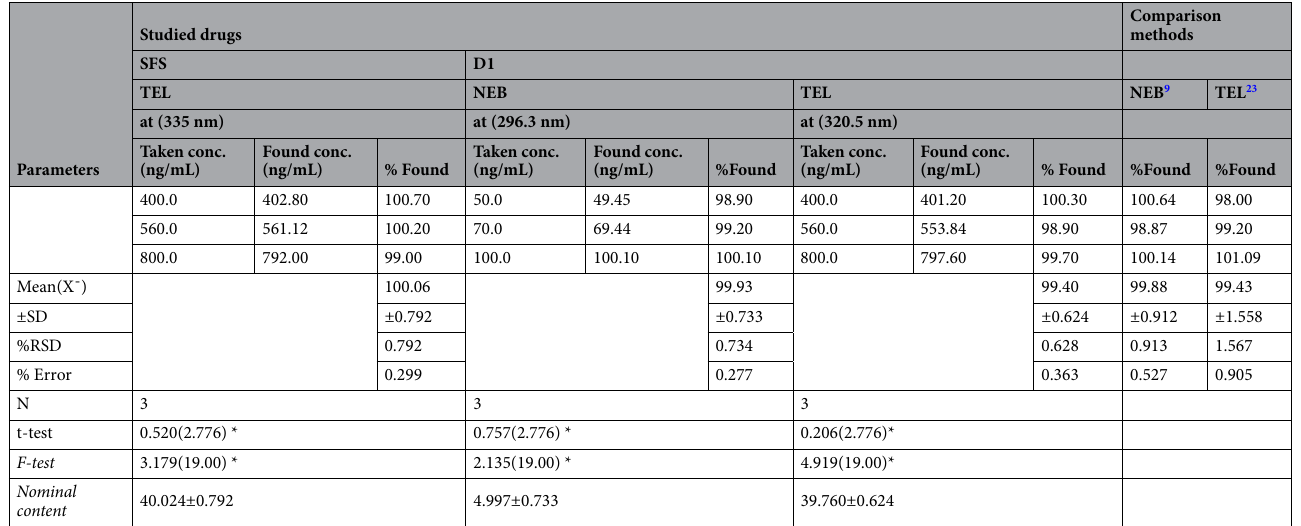
Table 5. Determination of TEL and NEB in dosage forms using the synchronous and first derivative synchronous spectrofluorimetric methods. N.B. Each result is the average of three separate determines. *The values between parentheses are the tabulated t and F values at P = 0.05 45